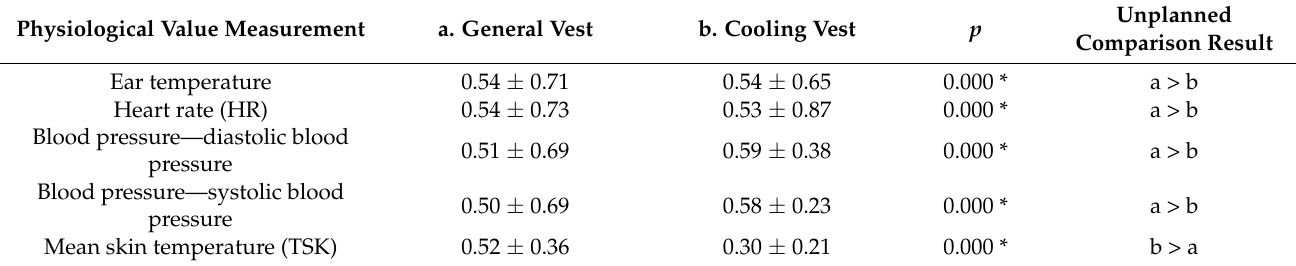
Table 7. Physiological measurements (Likert-type scale; mean ± standard deviation; and unit: %). Physiological Value